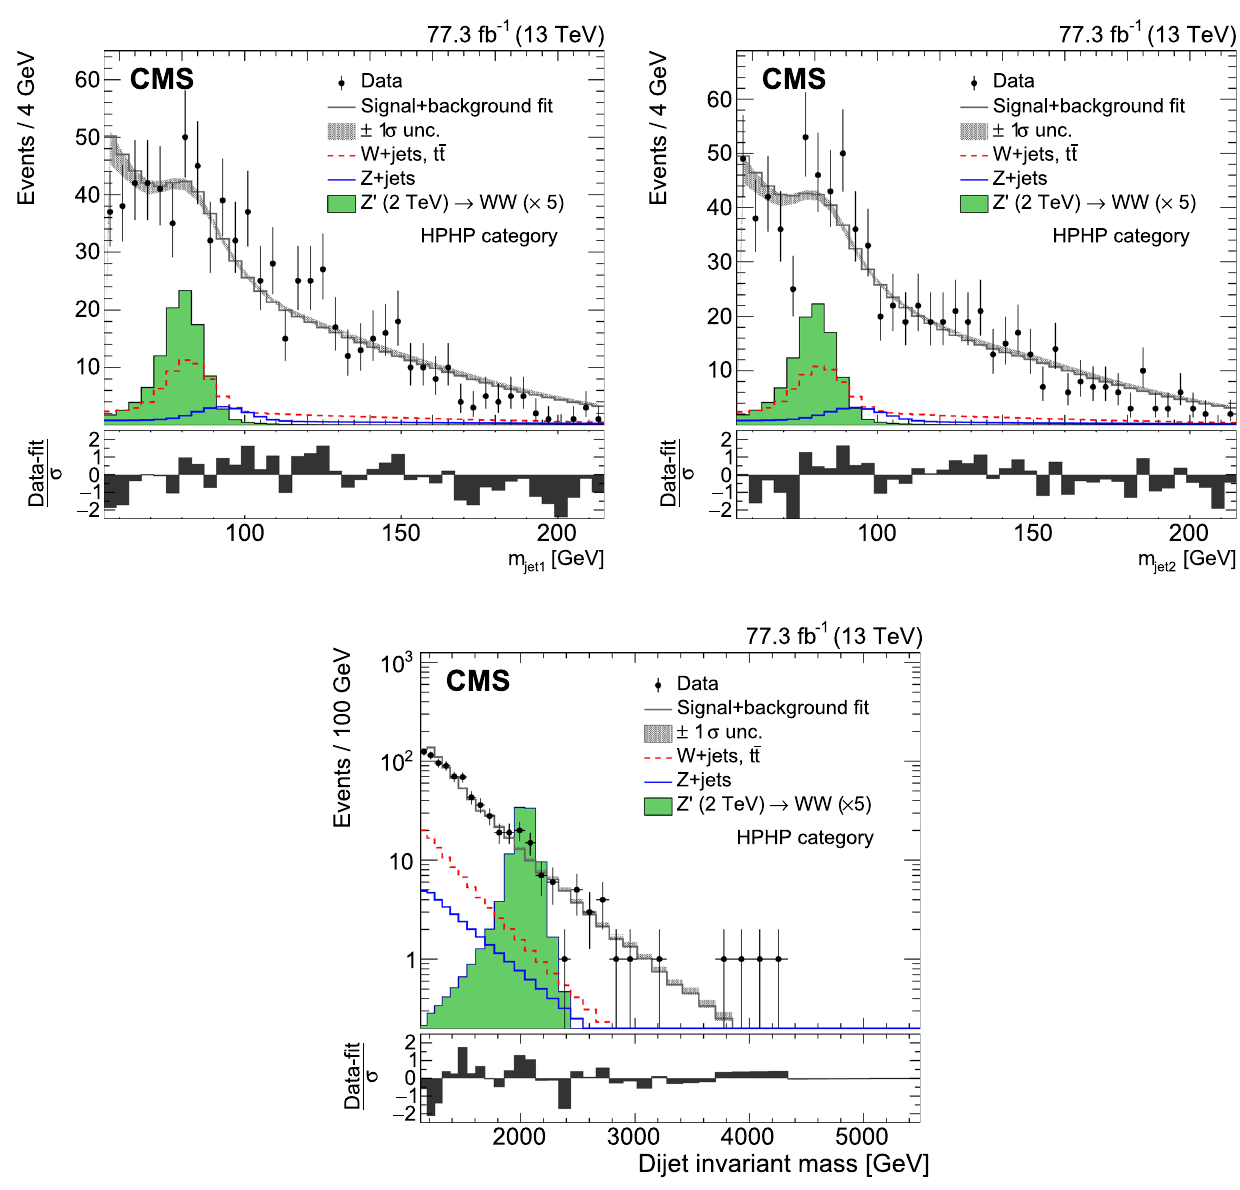
Fig. 10 For the HPHP category: comparison between the sig- nal+background fit and the data distributions of m jet1 (upper left), m jet2 (upper right), and m jj (lower). The background shape uncertainty is shown as a gray shaded band, and the statistical uncertainties of the data are shown as vertical bars. An example of a signal distribution is